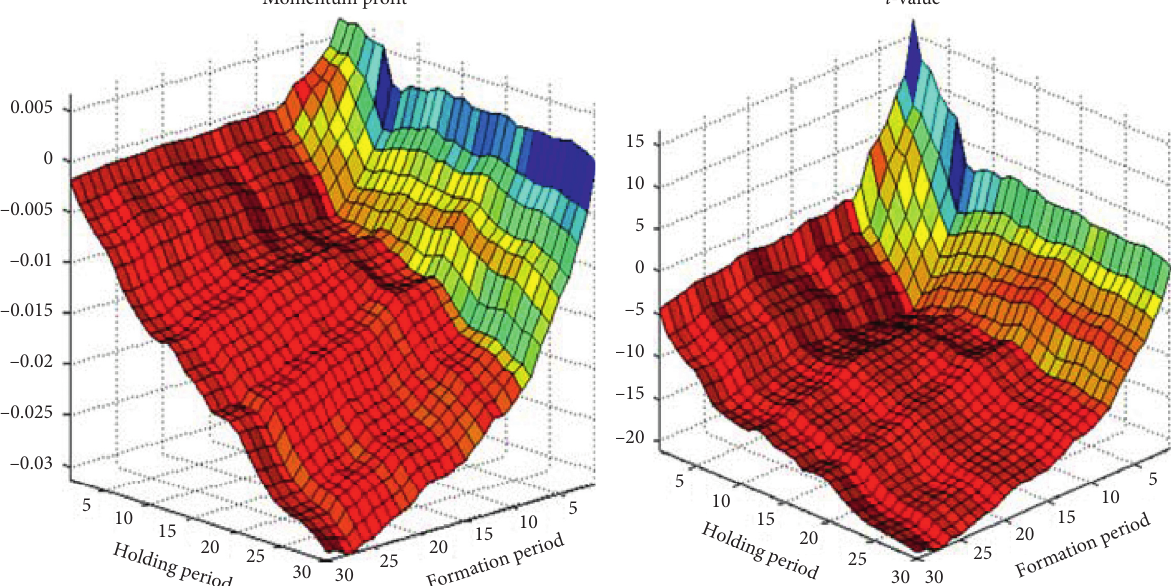
Figure 6: Lowest accumulative relative order imbalance in extensions of the A-share market. This figure plots the daily momentum profits and their t -statistics under the lowest accumulative relative order imbalance in A-share market. The formation and holding periods, respectively, range from 1 day to 30 days.